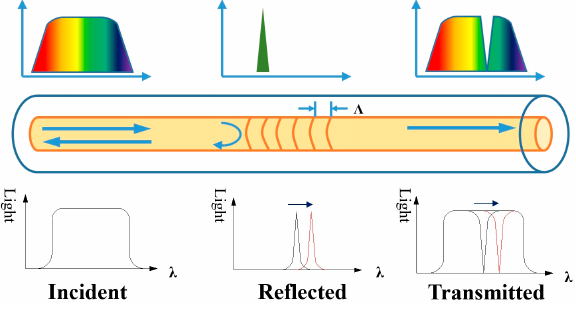
Figure 2. Schematic diagram of fiber Bragg grating sensing.